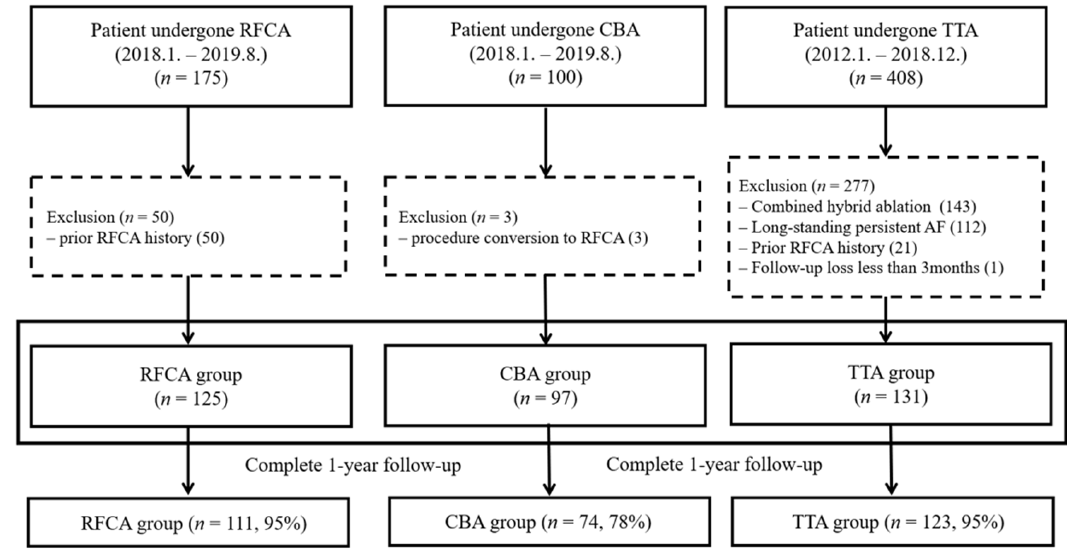
Figure 1. Study population.